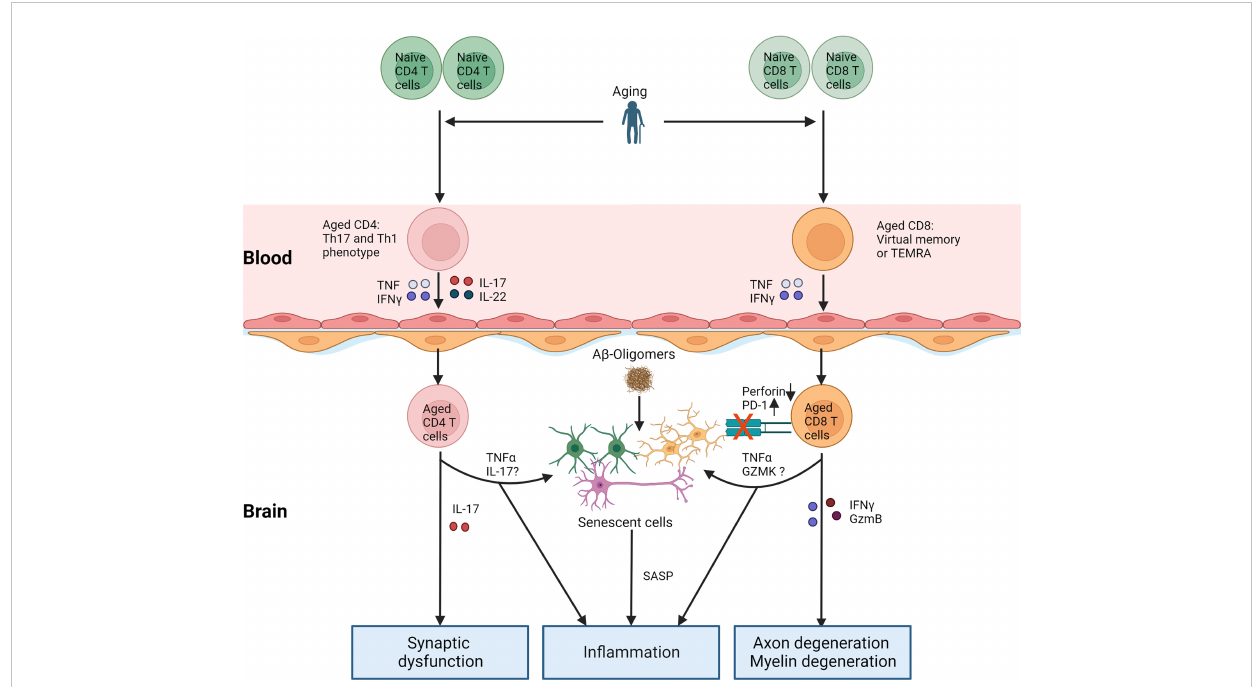
FIGURE 2 T cell aging and AD. With age, the number of naïve T cells decreases, and relative memory T cells (Th1 and Th17 for CD4 T cells, TEMRA, or virtual memory for CD8 T cells) accumulate. Cytokines secreted by aged T cells increase the permeability of BBB, which increases other immune cells or their entry into the brain. On the one hand, aged T cells in the brain directly contribute to neuroin fl ammation and damage to the nervous system by releasing cytokines. Aged T cells in the brain worsen the pathology of AD via the accumulation of senescent cells. TNF a , IL-17, and GZMK from aged T cells probably induce senescence in brain cells. Furthermore, increased PD-1 or decreased perforin in aged CD8 T cells in the brain inhibits the clearance of senescent cells. A b : amyloid b , TEMRA: T effector memory CD45RA+. SASP: senescence-associated secretory